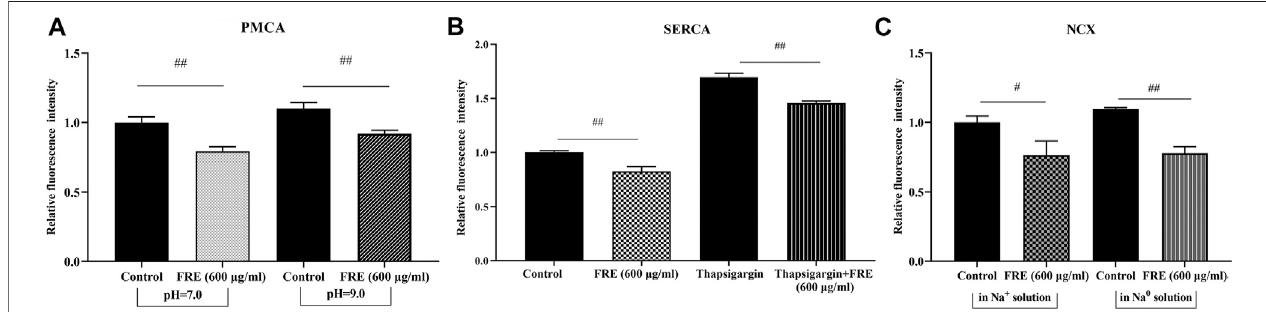
FIGURE6| FREdecreasesCa 2+ [c] independentofPMCA,SERCAandNCXinRBL-2H3cells( n (cid:2) 3 ). (A) EffectofPMCAonFRE-inducedCa 2+ [c] reduction.ThePMCA activity was determined by shifting the extracellular pH to 9.0. ## p < 0.01. (B) Effect of SERCA on FRE-induced Ca 2+ [c] reduction. Thapsigargin (5 μ M) was used to inhibit SERCA activity. ## p < 0.01. (C) Effect of NCX on FRE-induced Ca 2+ [c] reduction. The NCX activity was detected in a Na 0 solution containing 40 mM KCl. # p < 0.05, ## p < 0.01.